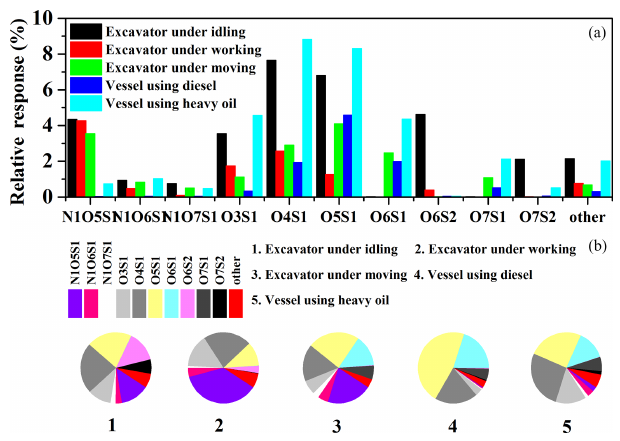
Figure 4. The distribution of subgroups of S-containing compounds for off-road